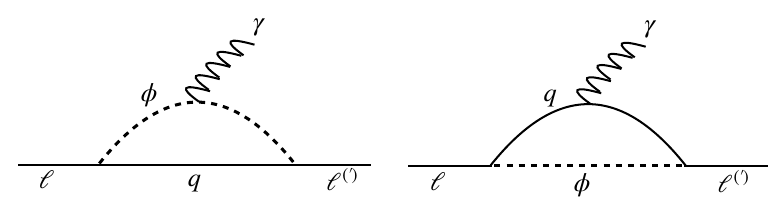
Figure 1 . Scalar leptoquark ( (cid:30) ) contributions to lepton dipole moments ( ‘ 0 = ‘ ) and ‘ ! ‘ 0 (cid:13)